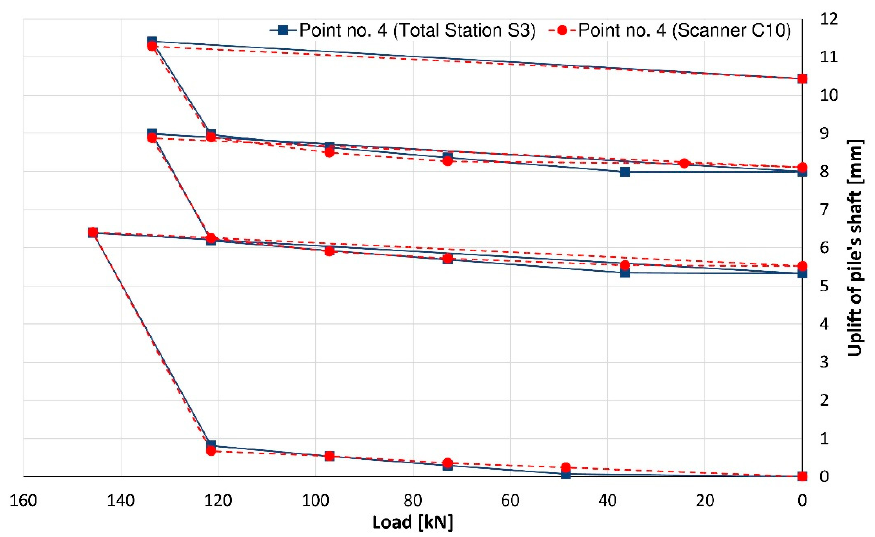
Figure 12. The uplift of the pile’s shaft represented by point no. 4.